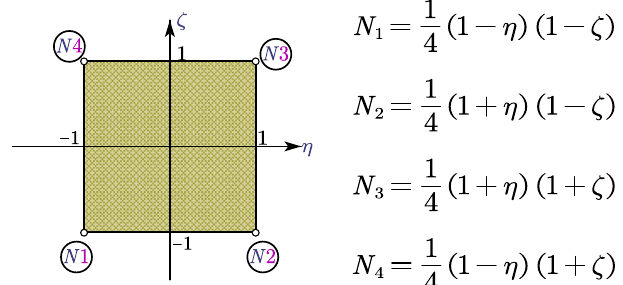
Figure 4. Four nodes linear plane finite